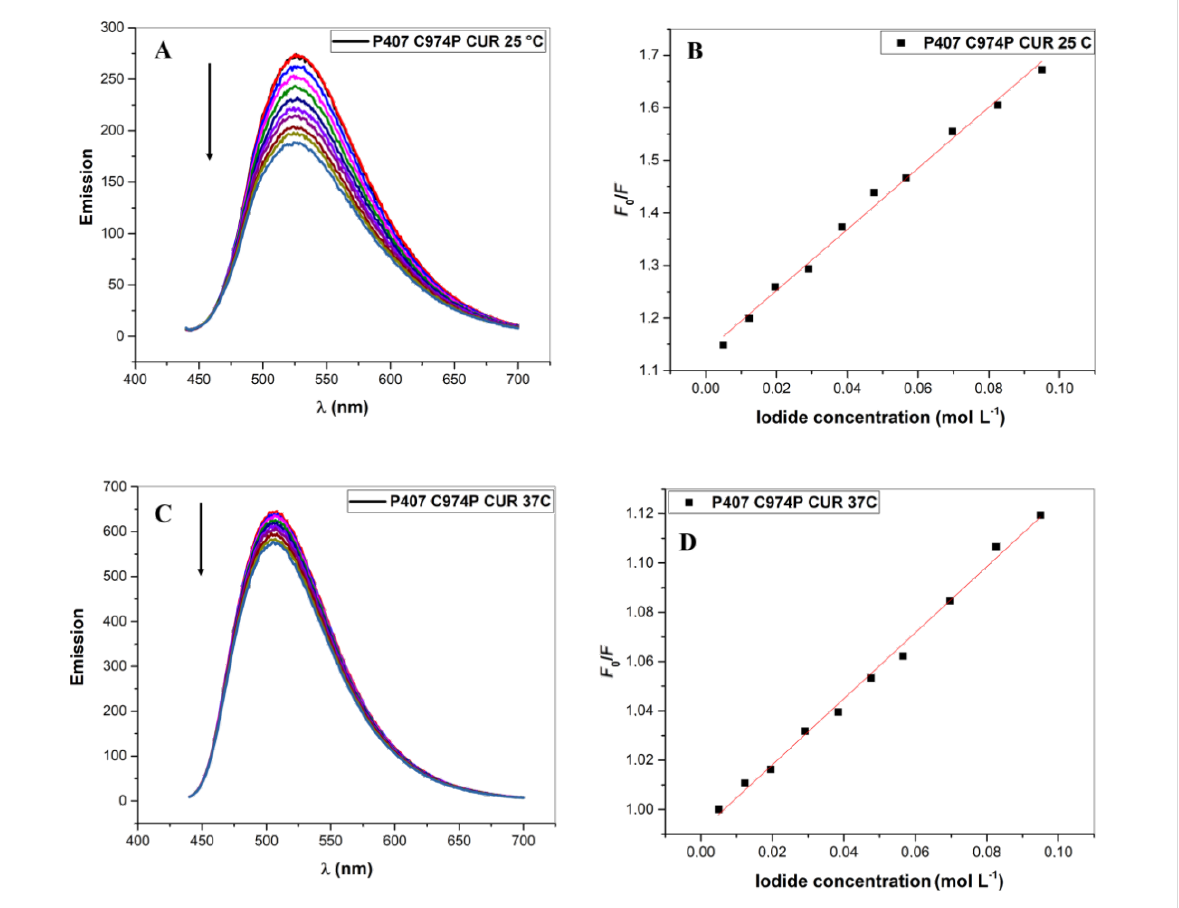
Figure 3: Fluorescence emission spectra and K sv determination by Equation 3 of CUR (3.6 × 10 − 5 mol/L) at 25 °C (A and B) and 37 °C (C and D) for P407 (0.2%, w/w) and C974P (3.2 × 10 − 4 %, w/w); λ exc = 422 nm with a 5–10 nm slit width. The spectral variation of CUR with I − concentration as de- termined by fluorescence emission at 25 °C (B) and 37 °C (D). The arrows in (A) and (C) indicate the fluorescence suppression direction of CUR with I −